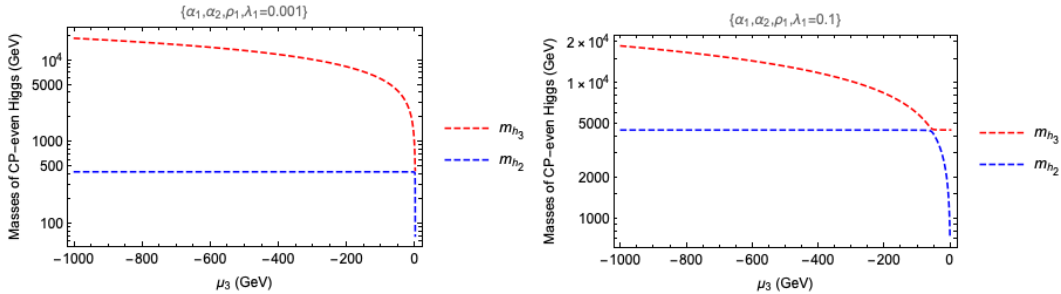
Figure 7 . Left Panel: CP-even Higgs masses as functions of µ 3 for α 1 = α 2 = λ 1 = ρ 1 = 0 . 001 . Right panel: CP-even Higgs mass as functions of µ